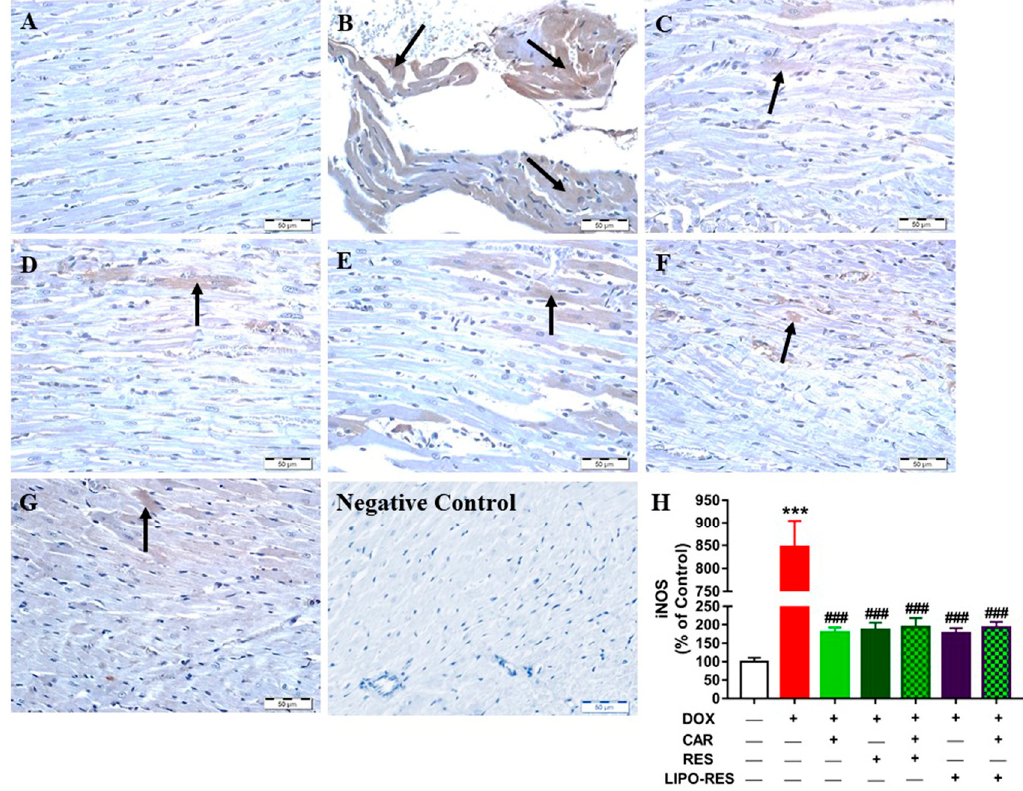
Figure 4. Photomicrographs of anti-iNOS-stained LV sections in: ( A ) Control rats showing the absence of immune reaction in cardiomyocytes cytoplasm and nuclei (arrow); ( B ) DOX-intoxicated rats showing multiple scattered foci of strong immune positivity; ( C ) CAR- ( D ) RES- ( E ) CAR/RES- and ( F ) LIPO-RES-treated rats showing moderate decrease in iNOS expression, and; ( G ) CAR/LIPO-RES-treated rats showing marked decrease in iNOS immune reactivity. ( H ) Mean ± SEM of iNOS immunostaining in LV sections of different groups, ( n = 6). *** p < 0.001 versus Control and ### p < 0.001 versus DOX.